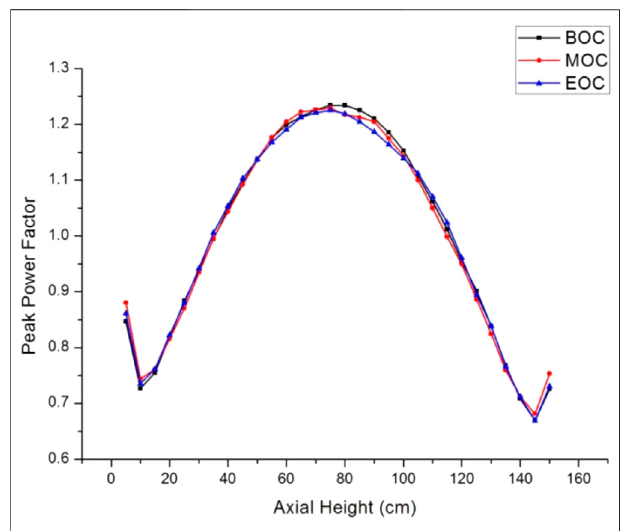
FIGURE 11 | Axial power distribution of